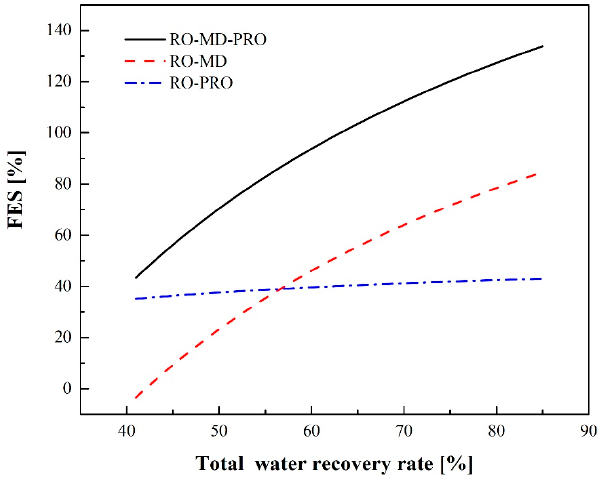
Figure 12. FES for different integrated processes.